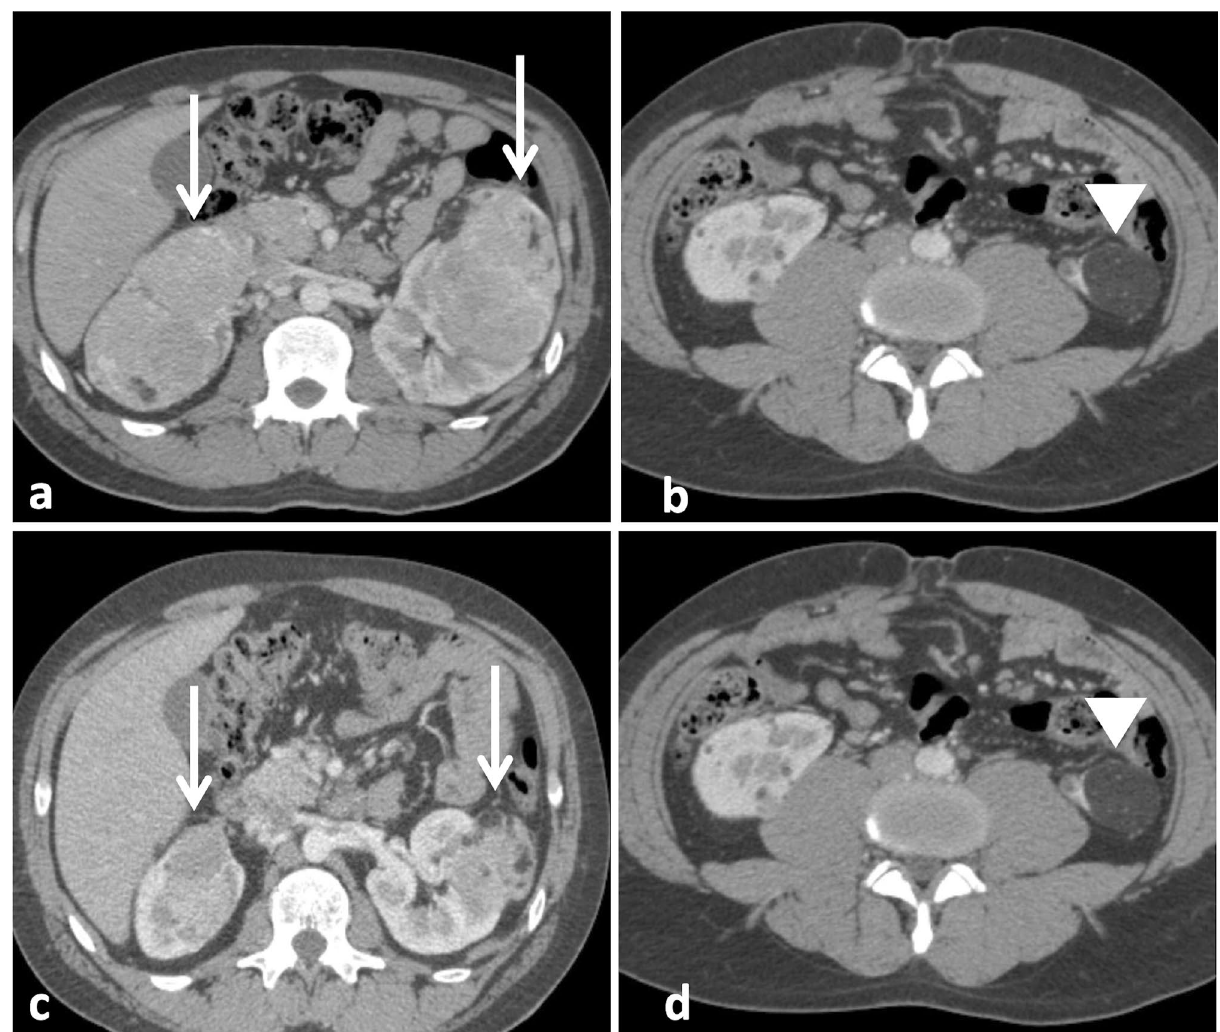
Figure 2. Response of renal AMLs to treatment with sirolimus. ( a , b ) Axial corticomedullary-phase CT images obtained before treatment show lobulated fat-poor AMLs in both kidneys (arrows) and a fat-rich AML arising from the lower pole of the left kidney (arrowhead). ( c , d ) Axial corticomedullary-phase CT images acquired after 7 months of treatment show significant volumetric reduction of the fat-poor AMLs (arrows) and nonsignificant change in the fat-rich AML (arrowhead).